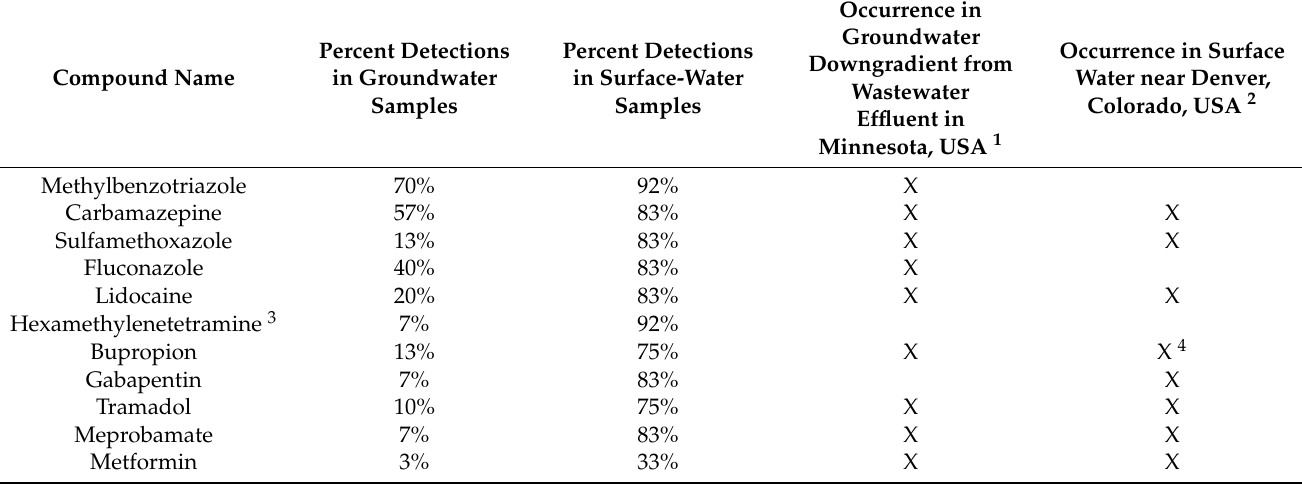
Table 1. Summary of percent detections of contaminants of emerging concern in water-quality dataset from groundwater and surface water associated with the Fountain Creek alluvial aquifer and occurrence of compounds from similar studies within the United